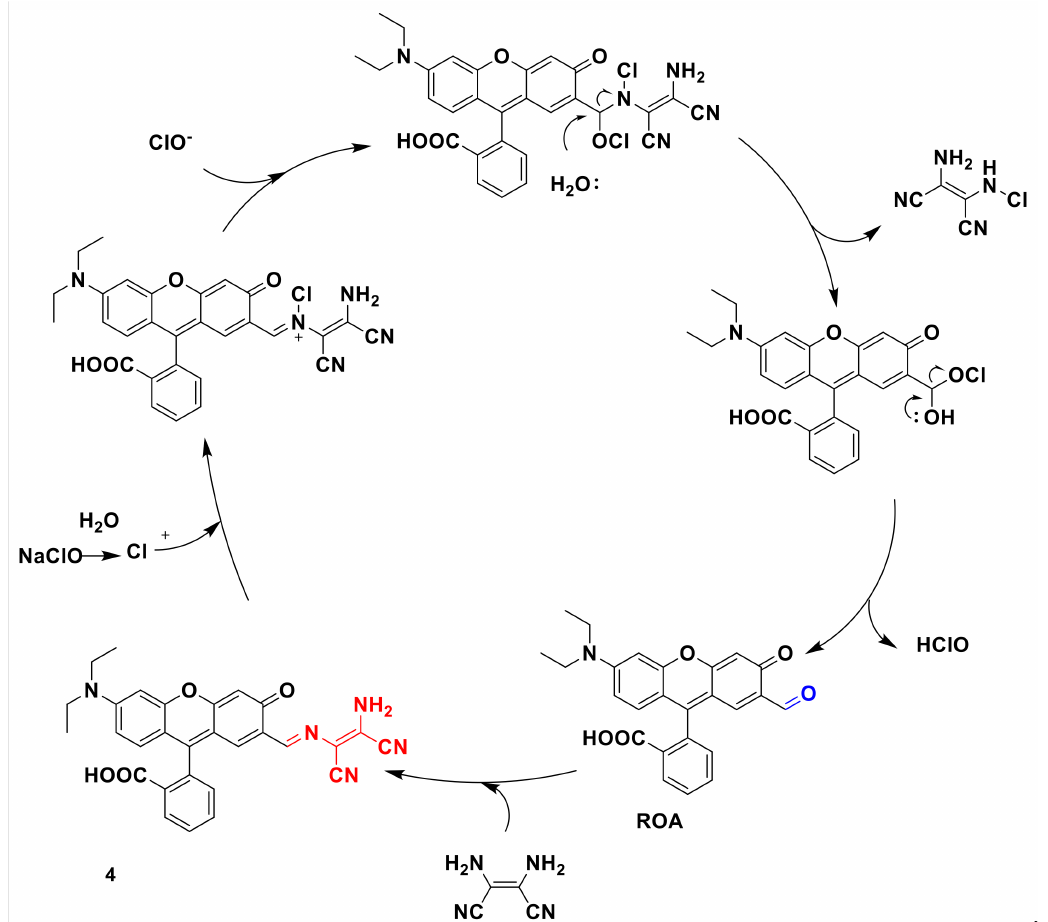
Figure 5. The recognition mechanism of probe